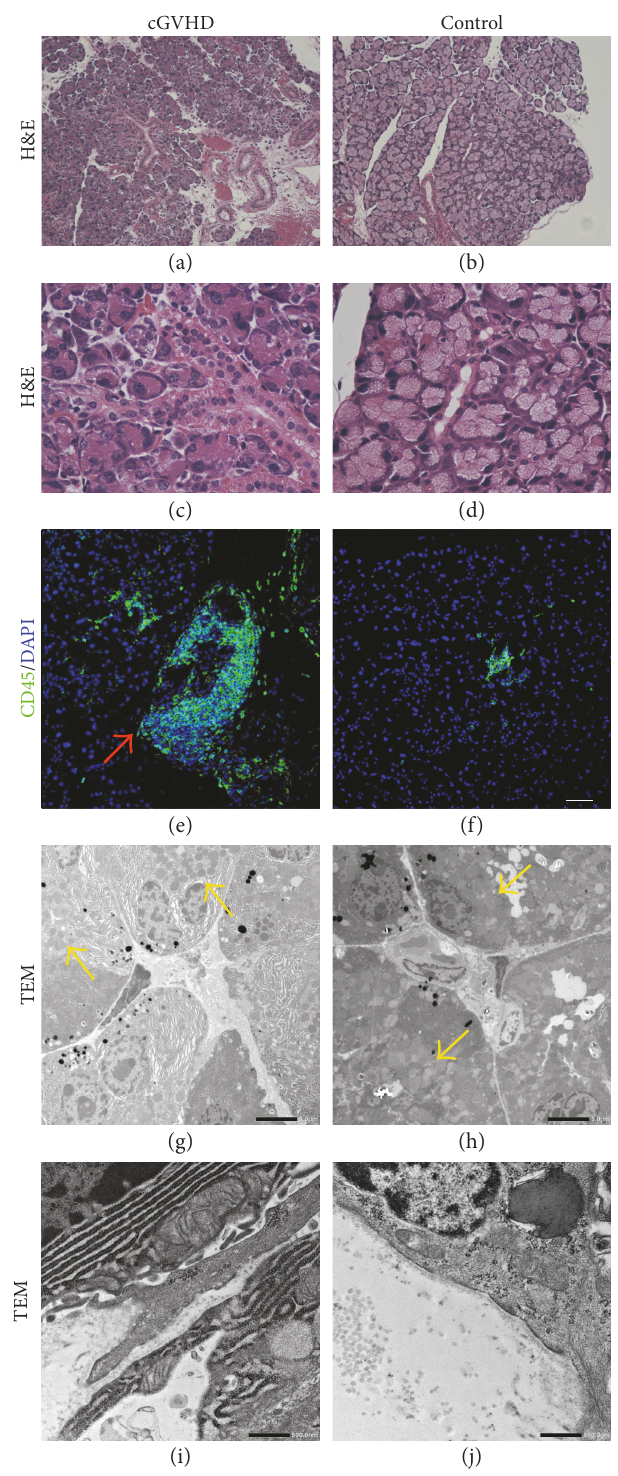
Figure 2: Characteristics histopathological fi ndings of lacrimal gland in a mouse model of cGVHD. Hematoxylin & eosin (H&E) staining for lacrimal gland tissue sections from GVHD-a ff ected mouse model (a, c) and syngeneic control (b, d). Immunostaining for CD45 + cells (in green and red arrow) and cell nuclei (stained with 4 ′ ,6-diamidino-2-phenylindole (DAPI) in blue) in the lacrimal gland collected from the GVHD-impaired mice (e) and syngeneic controls (f). Transmission electron microscopic (TEM) fi ndings of the lacrimal gland in a mouse model of cGVHD (g, i) and the syngeneic controls (h, j). (g, h) Yellow arrows, secretory vesicles. Scale bar =50 μ m (a, b), 25 μ m (c, d), 50 μ m (e, f), 5 μ m (g, h), and 0.5 μ m (i, j). cGVHD mice, n = 10 ; syngeneic control mice, n = 10 . Representative fi gures from three independent